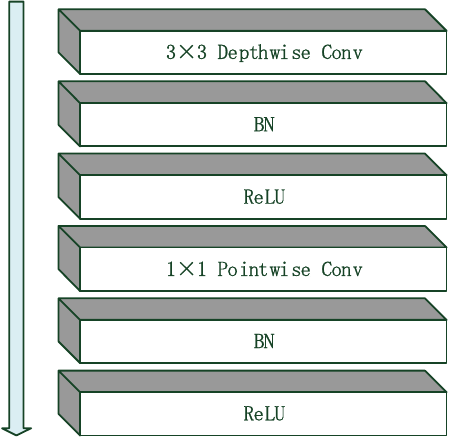
Figure 4. Basic structure convolution layers of MobileNet.